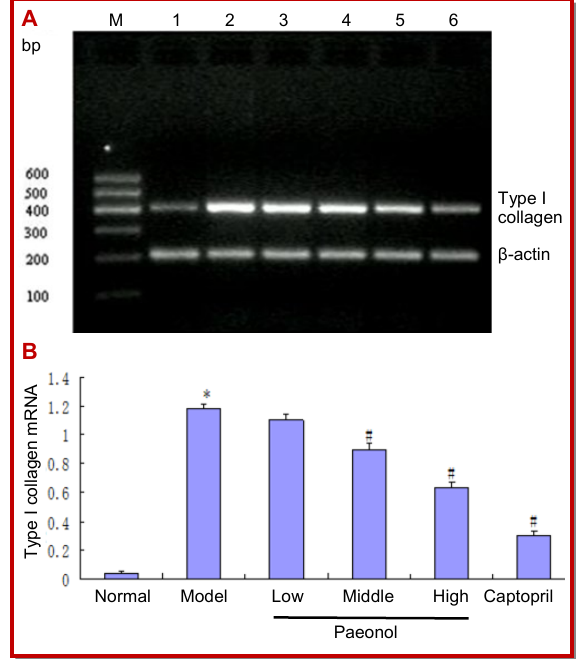
Figure 3: The type I collagen mRNA expression of cardiac fibroblasts in each group by RT-PCR. 1-the normal control group; 2-aldos-terone model group; 3-the low-dose group of paeonol; 4-middle-dose group of paeonol; 5-the high-dose group of paeonol; 6-the captopril group; M Marker (A); Com- pared with the normal control group, *p < 0.01; compared with the model group, # p < 0.01 (B)